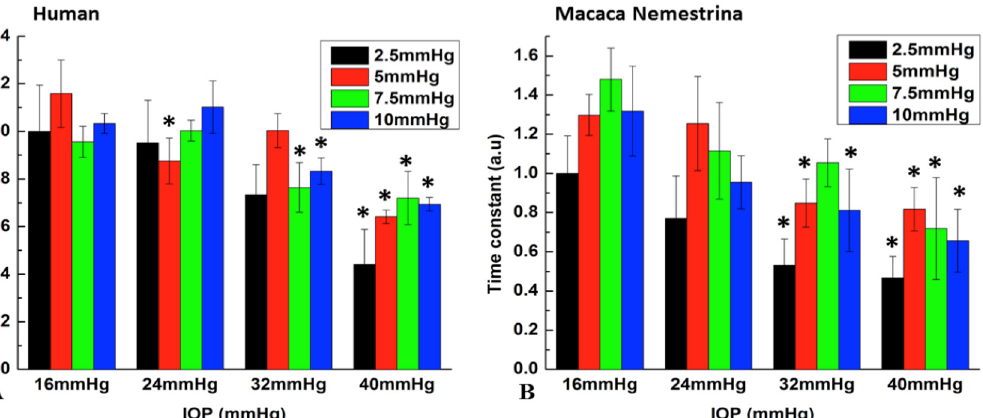
Figure 5. The mean and standard deviation of trabecular meshwork recoil time constant for ( A ) humans and ( B ) nonhuman primates (Macaca Nemestrina). IOP: intraocular pressure. Each graph normalized all values to the 16 mmHg IOP and 2.5 mmHg pulse amplitude (i.e., first black bar). * indicates significant differences between groups. Each data point is the average of 4 measurements. Table 1. p -value for TM recoil time constant over different mean pressures and pulse amplitudes. Human Eye Monkey Eye